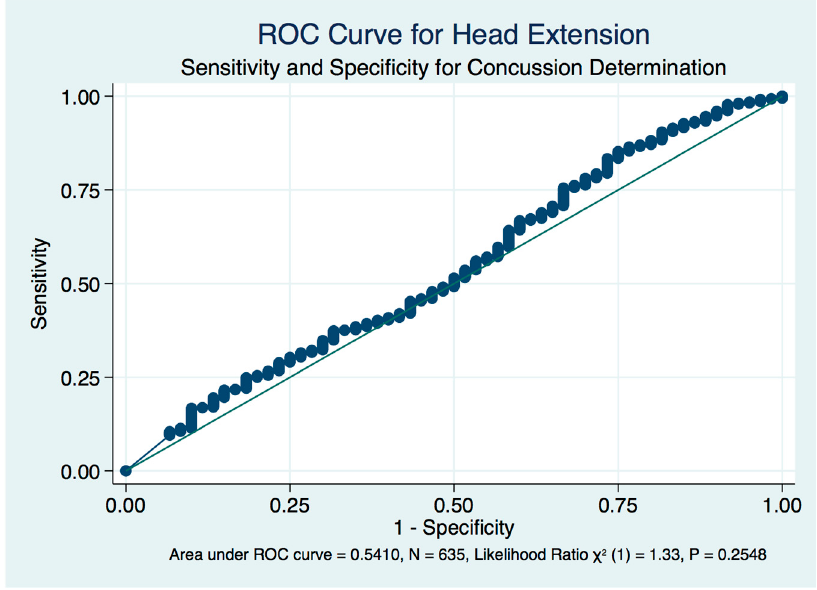
Figure 12. ROC curve for head extension, eyes closed perturbed testing in concussion determination.